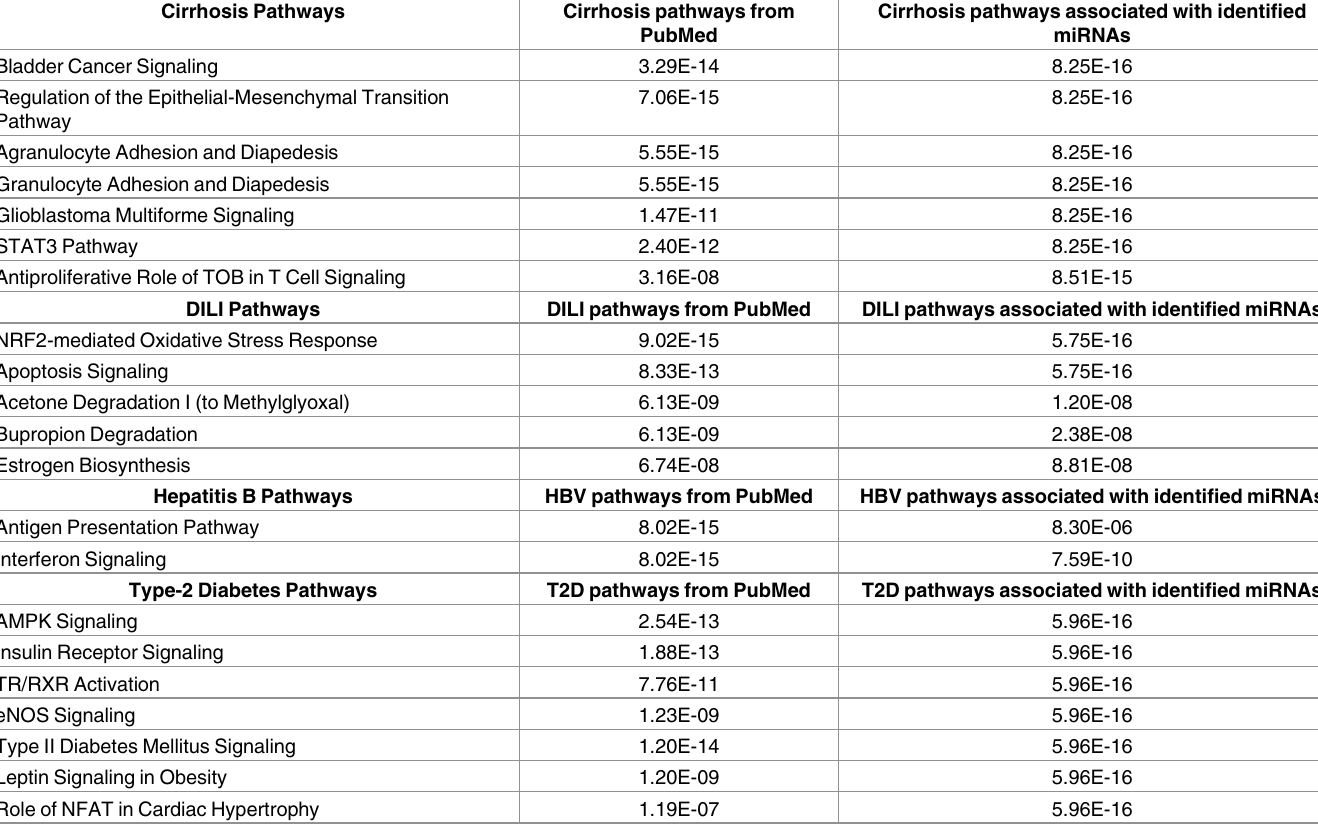
Table 1. Comparison of pathways derived from literature analysis with pathways derived from miRNA target